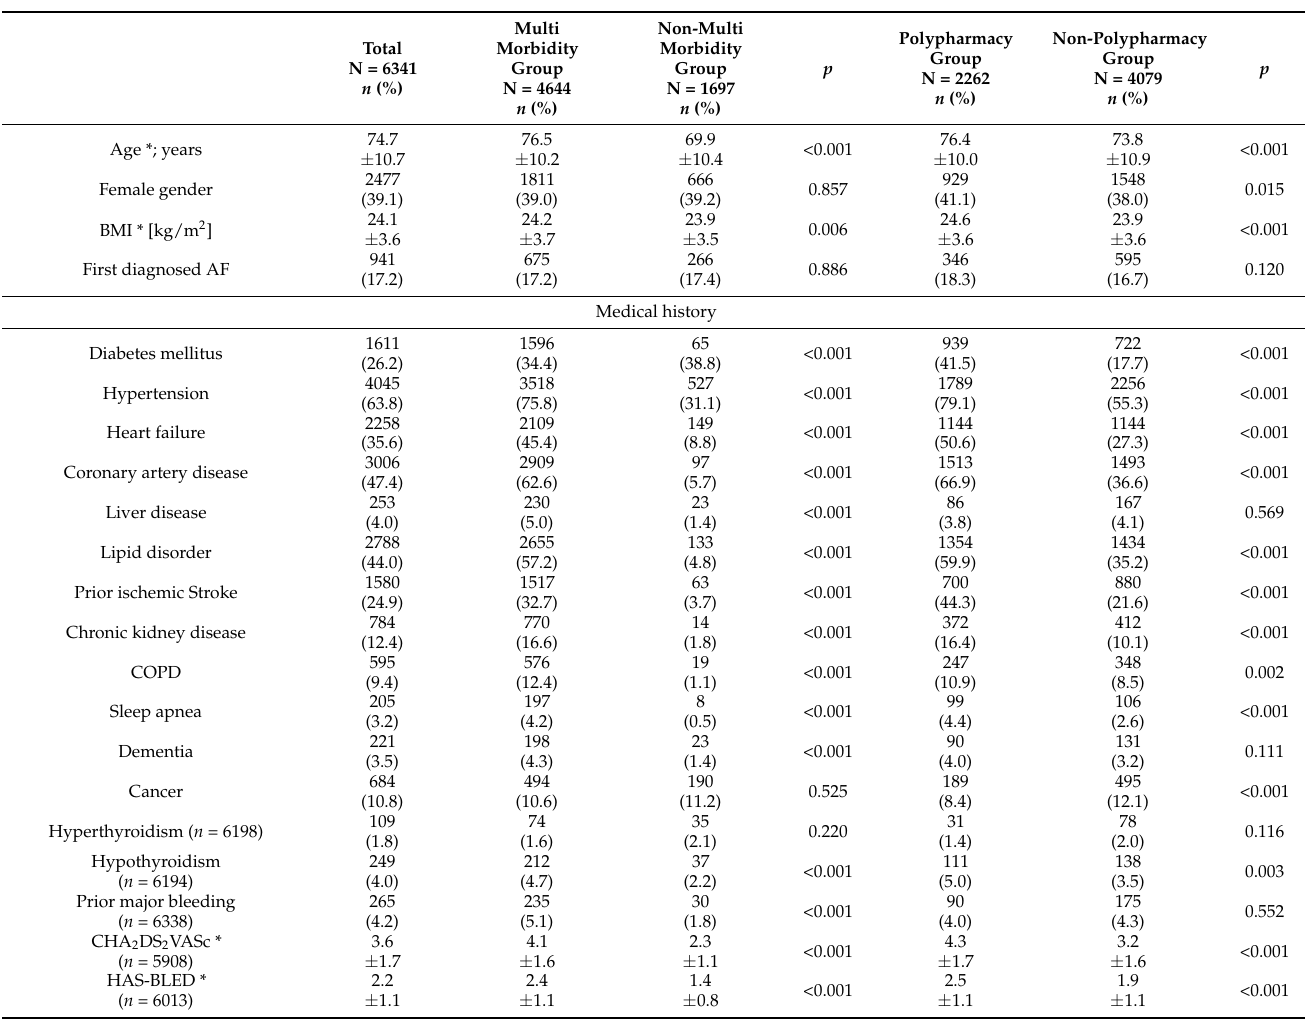
Figure 1. Flowchart of patient inclusion. ChiOTEAF: Optimal Thromboprophylaxis in Elderly Chinese Patients with Atrial Fibrillation. Table 1. Baseline characteristics of the study cohort.